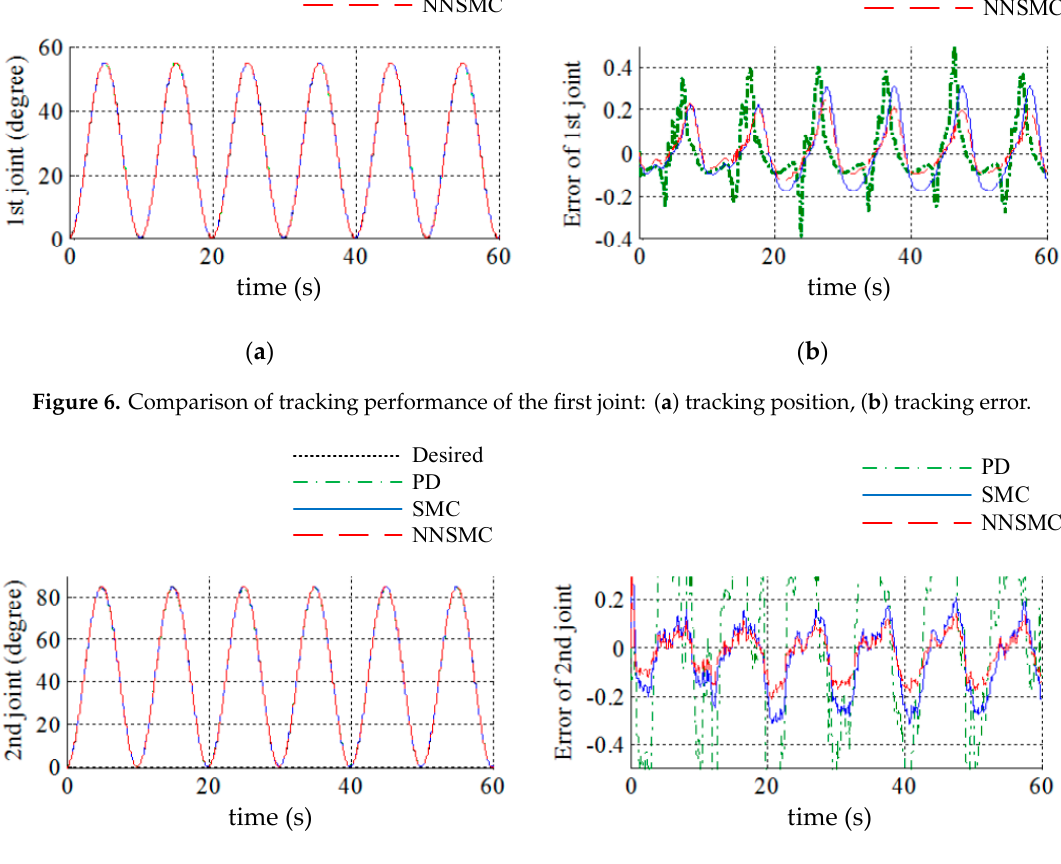
Figure 7. Comparison of tracking performance of the second joint: ( a ) tracking position, ( b ) tracking error.